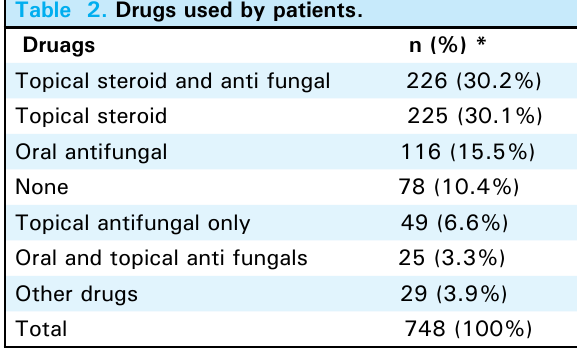
Table 2. Drugs used by patients.